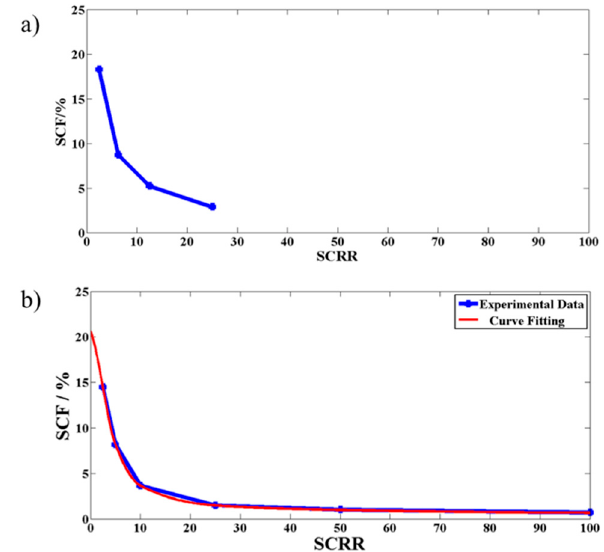
Figure 6. The effect of the side to the central channel hydraulic resistance ratio ( SCRR ) on the side to the central channel flow rate ratio ( SCF ). ( a ) The simulation results demonstrating the effect of SCRR on SCF . ( b ) The experimental results showing the variation of SCF with respect to SCRR .